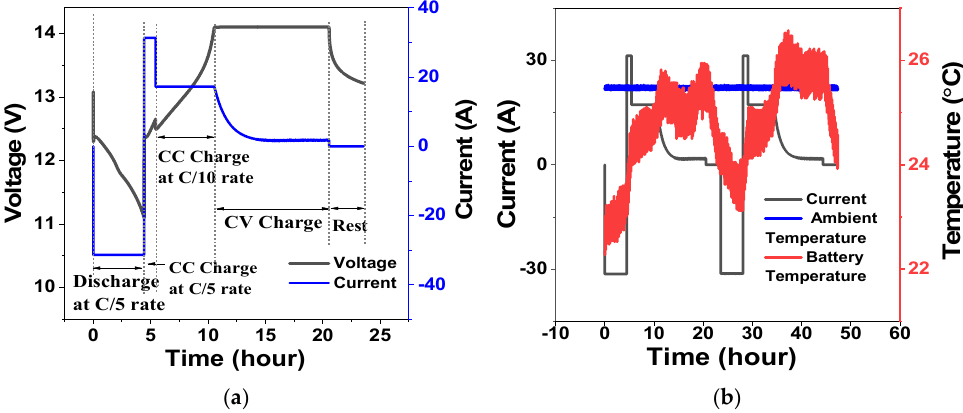
Figure 3. ( a ) Voltage and current profile of the capacity test; positive current is charge; ( b ) Temperature and current profile of the capacity test.